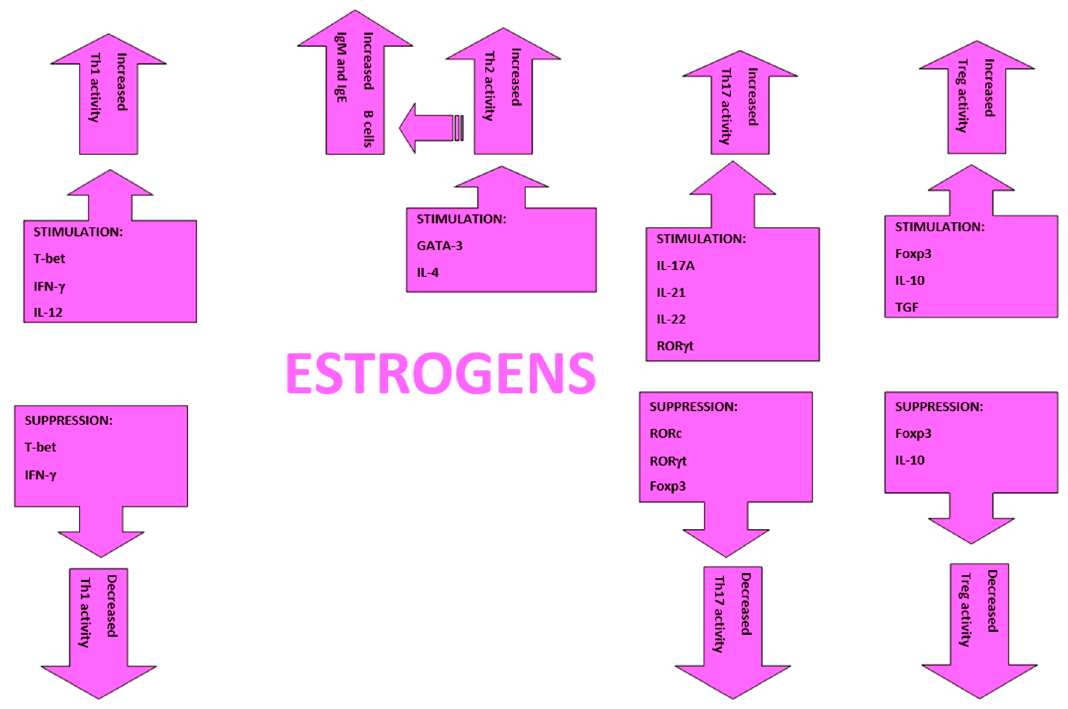
e ff ects on Th2 production of IL-4 and Th17 production of IL-17A. Estrogen and progesterone increase Th17 cells expression of IL-23R and IL-17A production, as well as increase airway inflammation mediated by IL-17A [12].